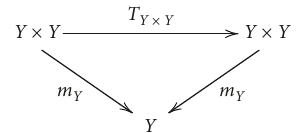
Figure 10: A commutative diagram.